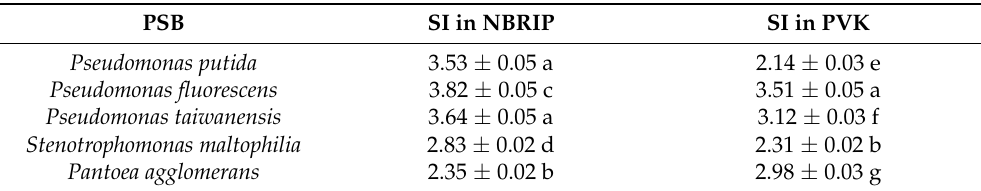
Table 3. Phosphate solubilization index of PSB isolates (mean ± confidence interval, n = 3). Same letters indicate that the difference between the means is not statistically significant.